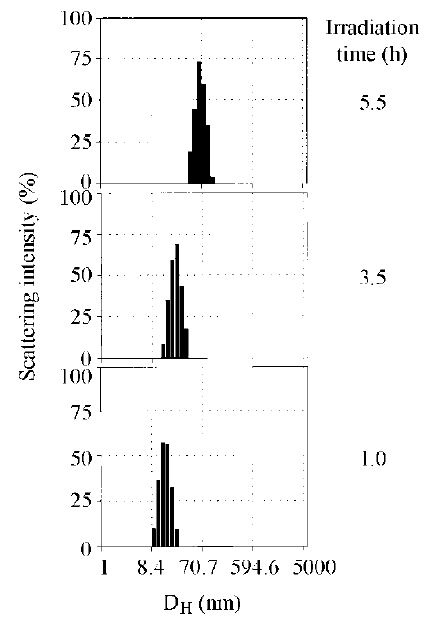
Figure 2. Scattering intensity distributions of the hydrodynamic diameter of the copolymer. [copolymer] = 3.30 0